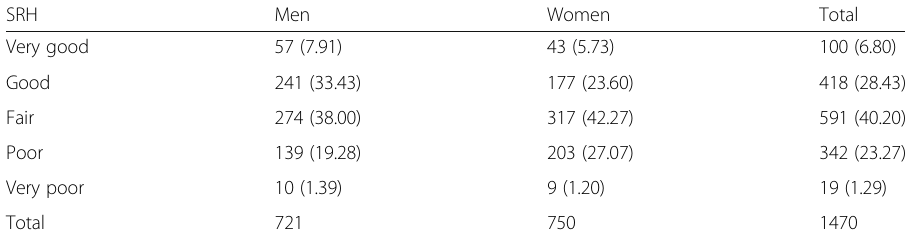
Table 7 Gender difference in elders ’ self-rated health